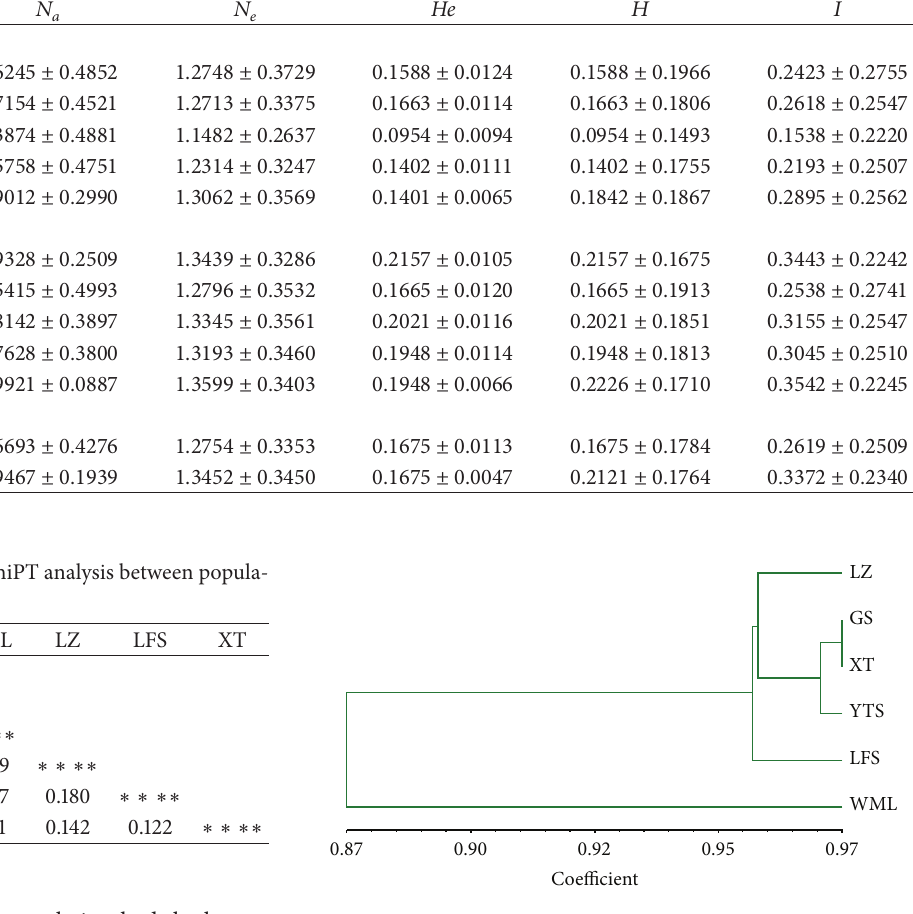
Figure 2: UPGMA cluster analysis of the six populations (two species) based on ISSR